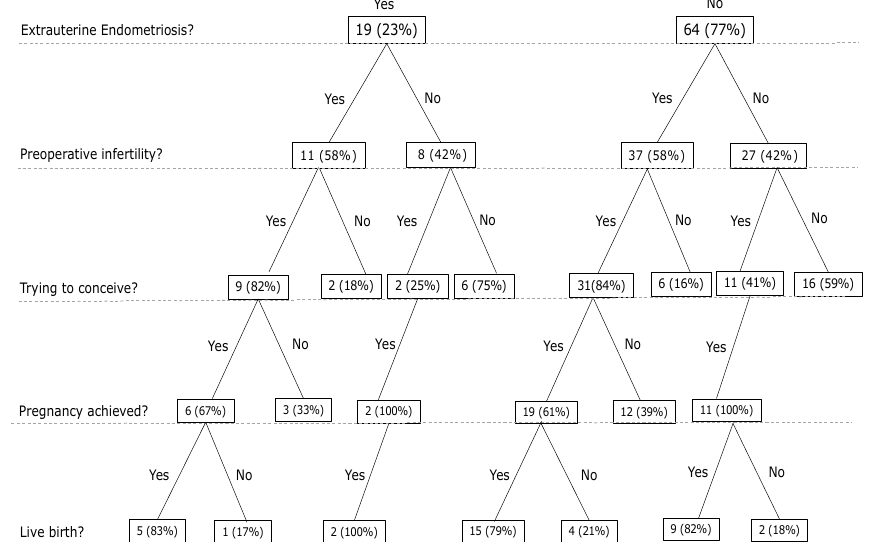
Figure 2. A systematic overview of sample size of patients with and without endometriosis after the operation.